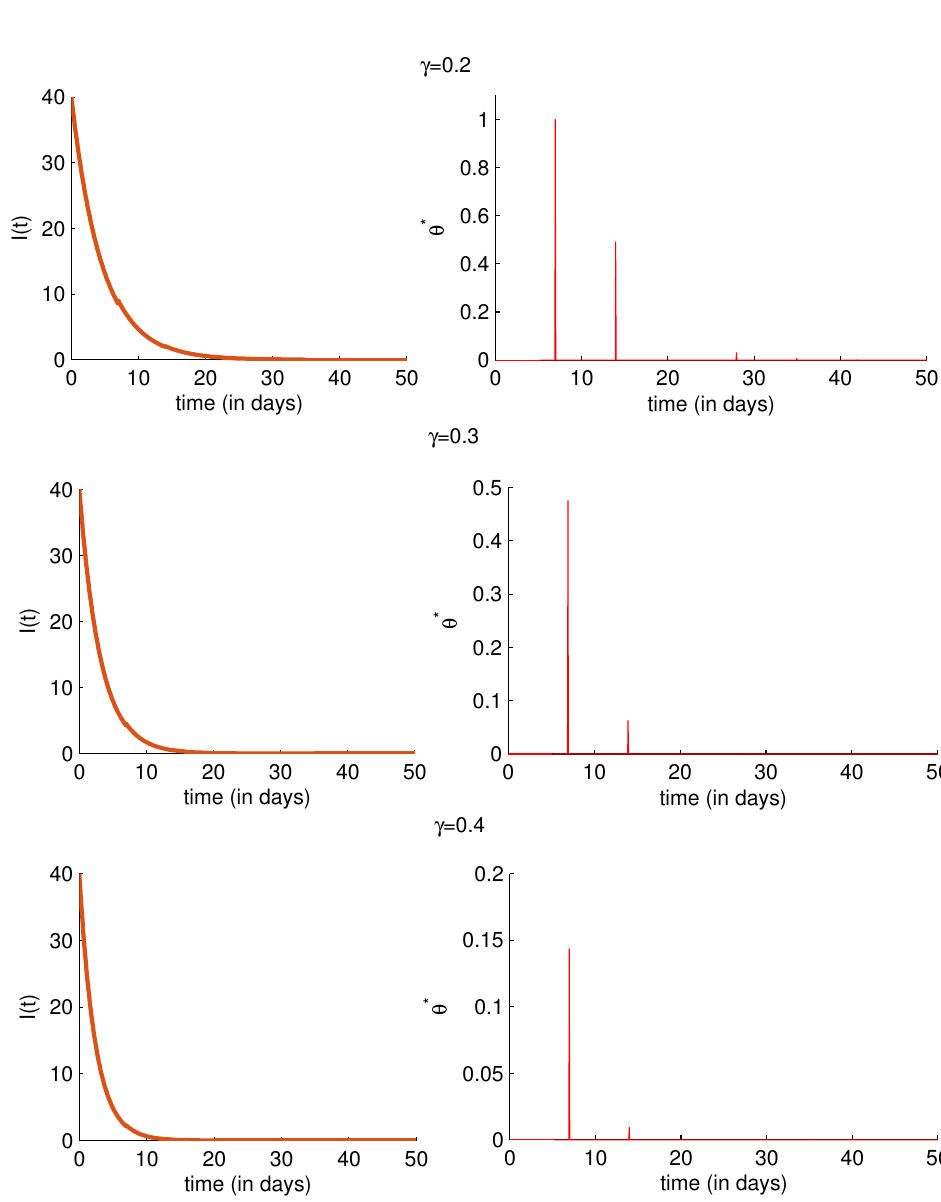
Figure 7. Infection and impulse optimal controls for different values of γ and β = 0.0003. The other parameters are the same as in Figure